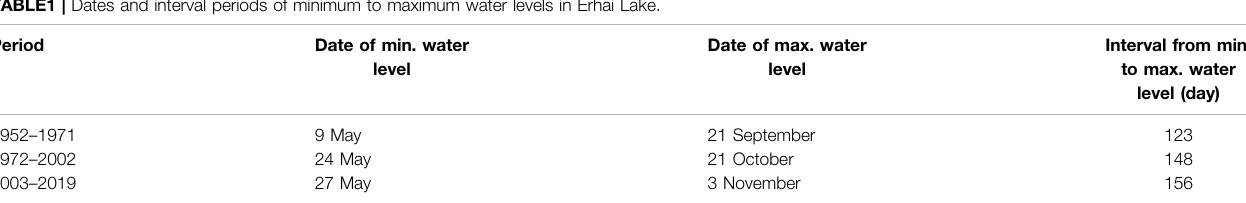
TABLE1 | Dates and interval periods of minimum to maximum water levels in Erhai Lake. Period